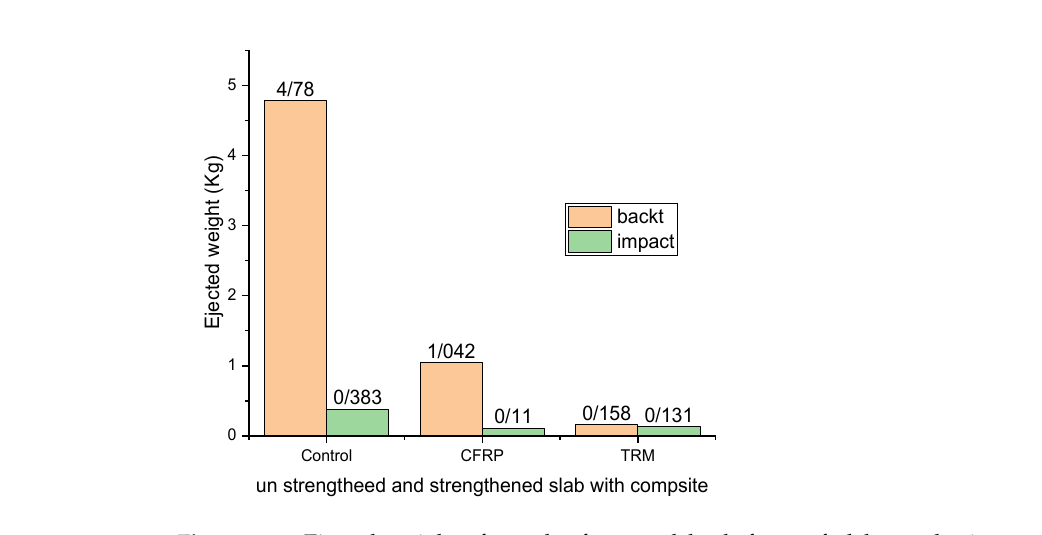
Figure 24. Ejected weights from the front and back faces of slabs at the impact velocity of 135 m/s [111].